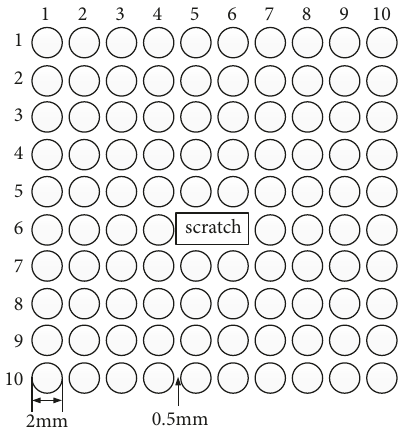
Figure 1: Schematic diagram of scratch